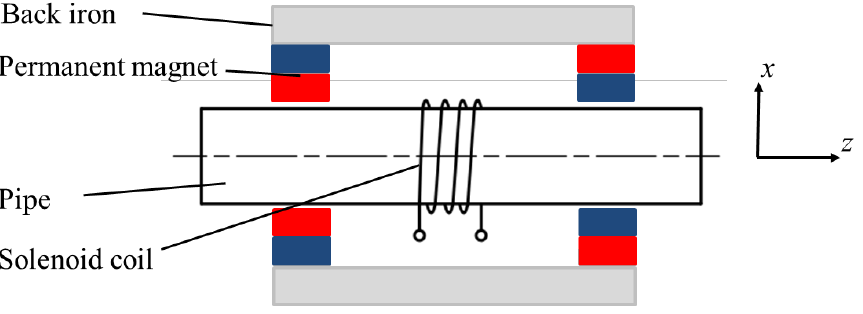
Figure 4. The conventional structure of the transmitter for the longitudinal guided wave